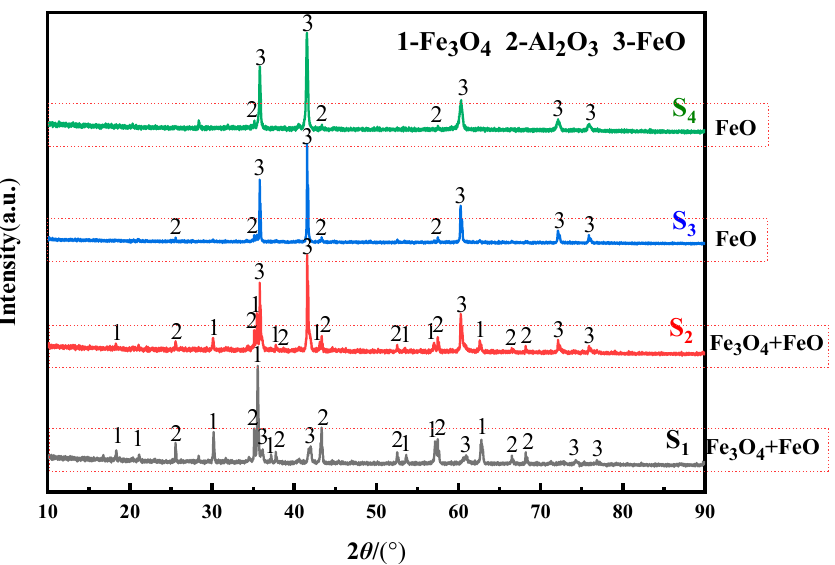
Figure 3. XRD patterns of oxide electrolysis products with different raw material